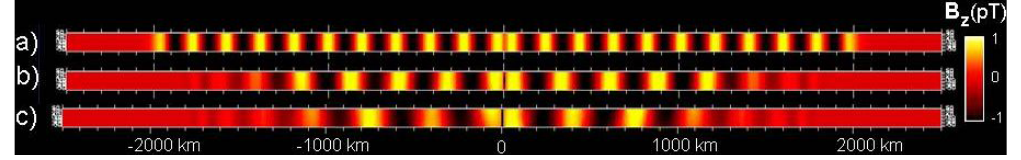
Fig. 3. Plane wave runs in the HYB-em model: The magnetic field. The oscillating plane source is located at x =0 and its frequency is 1.5kHz. The colors in panels (a–c) show the z component of the magnetic field from − 1 × 10 − 12 T ( = − 1pT) to 1 × 10 − 12 T (=1pT) at t =6.96ms, i.e. just before the plane wave reaches the faces of the simulation box at x = ± 2500km. In all panels the horizontal axis is the x-axis from − 2500km to +2500km, and the vertical axis corresponding to the z-axis from − 50km to +50km. The magnetic field is derived at the y =0 panel. Panel (a) shows the electromagnetic plane wave in a vacuum. In panels (b) and (c) the simulation box was filled initially with the plasma of electron density of ∼ 0.016cm − 3 and ∼ 0.021cm − 3 ,